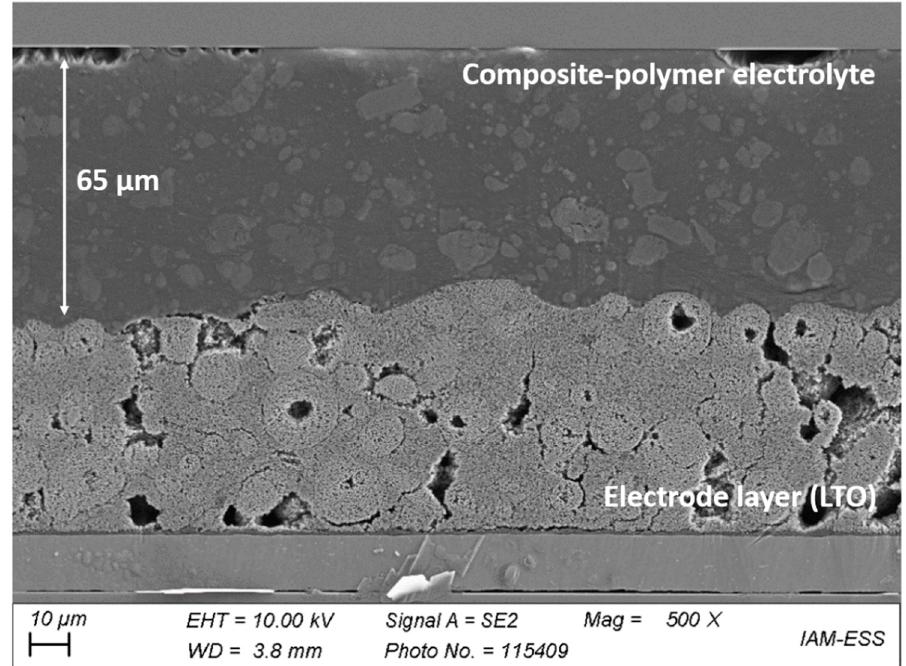
Figure 6. Scanning electron microscope image of the cross-section of a polymer electrolyte coated LTO electrode; 500× magnification.